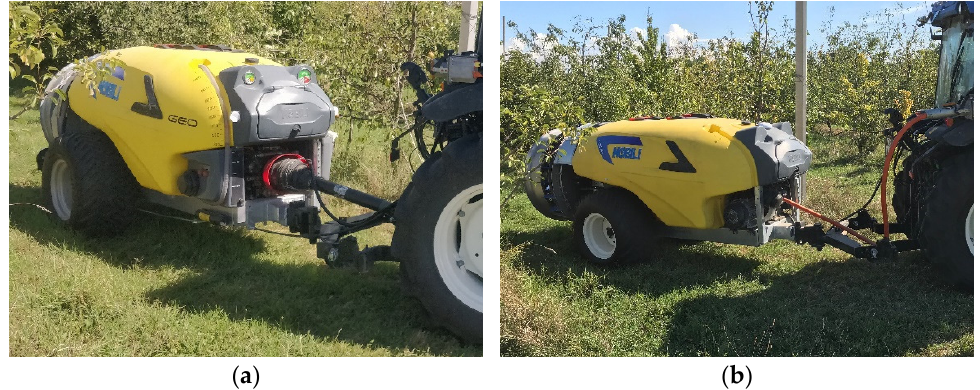
Figure 2. mSprayer ( a ) and eSprayer ( b ) developed by Nobili S.p.a. (Molinella (BO), Italy) used for the tests.